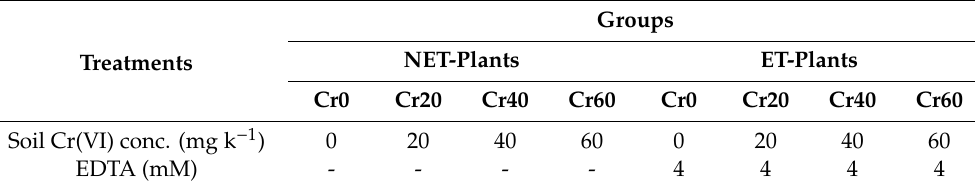
Table 5. Experimental design showing groups and treatments. Groups NET-Plants ET-Plants Treatments Cr0 Cr20 Cr40